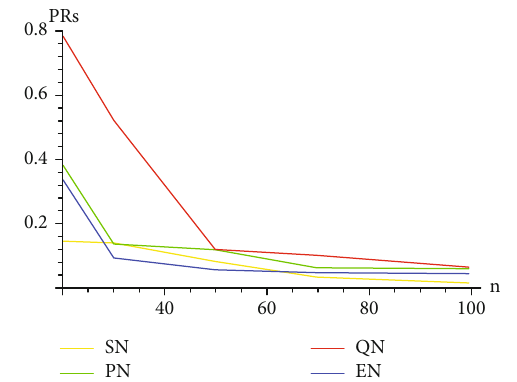
Figure 6: Graph of PRs under di ff erent LFs using NIP for γ = 0 : 1 , using λ = 0 : 5 . Table 12: Comparison of BIID with class of EGDs using real dataset-1.